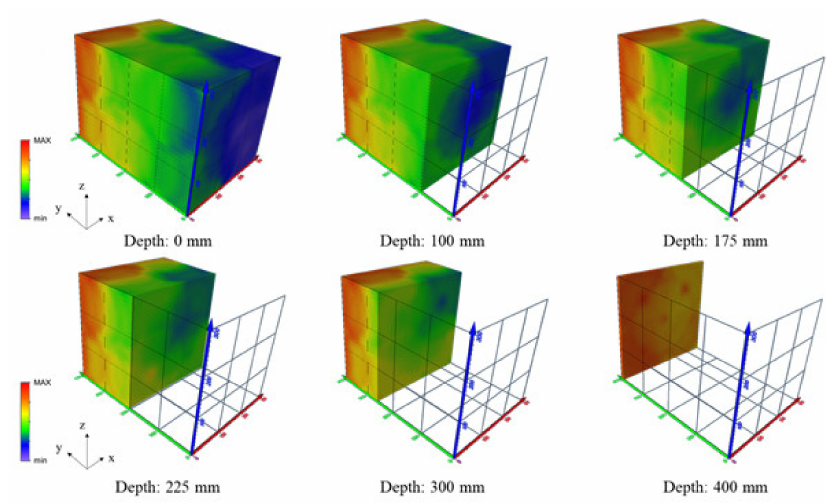
Figure 17. 3D SIBIE result with LDV signal detection for intact concrete